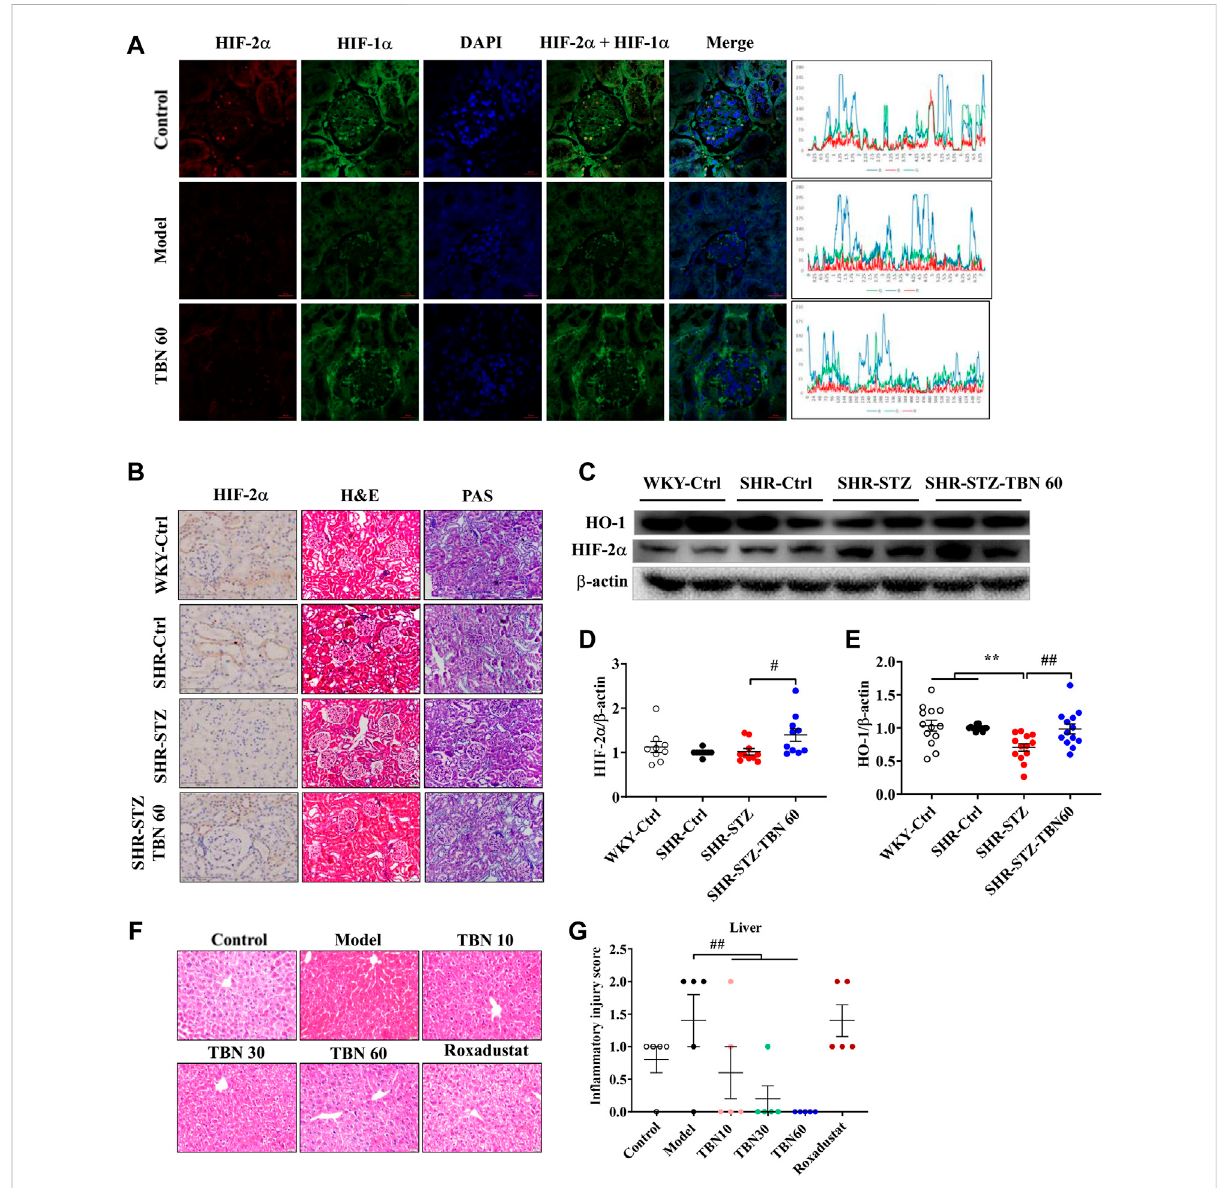
FIGURE 3 TBN increases the expression of HIF-1 α and HIF-2 α in CDDP-induced anemia C57BL/6J mice and SHR rats. (A) Representative images of the expression of HIF-1 α and HIF-2 α by immuno fl uorescence co-staining experiment, (original magni fi cation:×630). Scale bar, 20 μ m. The Y-axis is the average value of fl uorescence intensity obtained by immuno fl uorescence analysis through Image J software. The peaks as shown along with the immuno fl uorescence images represent the highest expression of the whole images. The X-axis is the length of the images. The formula of fl uorescence intensity in a speci fi c area is as follows: Mean fl uorescence intensity (Mean) = Total fl uorescence intensity (IntDen)/Area of the region (Area). Mean: Mean gray value, IntDen: Integrated Density. (B) Representative images of H&E staining and PAS staining (original magni fi cation: ×200) ofkidneytissue.Scalebar,50 μ m.RepresentativeImmunohistochemistrystainingofHIF-2 α (originalmagni fi cation:×400).Scalebar:100 μ m. (C – E) RepresentativewesternblotofHIF-2 α andHO-1( n =8foreachgroupinFigure (D) ; n =13foreachgroupinFigure (E) . (F,G) Representativeimagesof HE staining (×200) of liver tissue and in fl ammatory injury score in CDDP-induced C57BL/6J mice ( n = 5 for each group in Figure (G) . ** p < 0.01 vs. SHR-control; # p < 0.05; ## p < 0.01 vs. SHR-STZ. ## p < 0.01 vs. vehicle-treated CDDP group. HIF, hypoxia-inducible factor; CDDP,